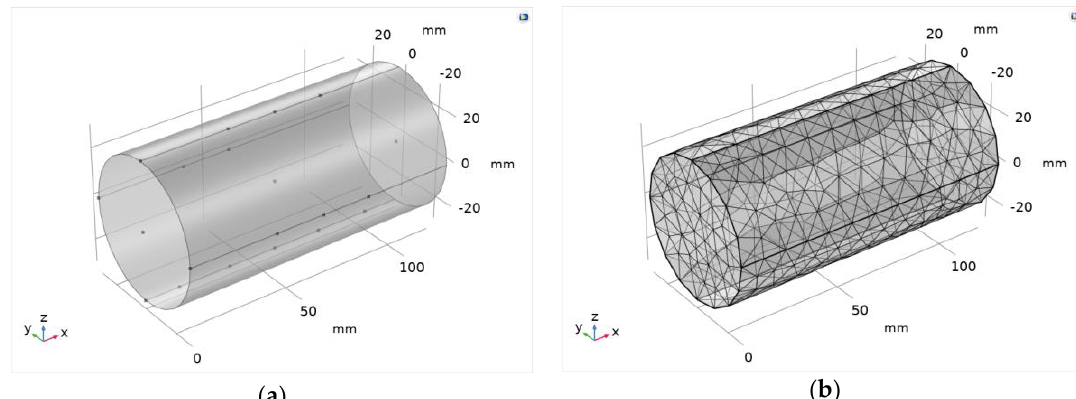
Figure 2. Verification study – numerical model ( a ) geometry and ( b ) mesh.